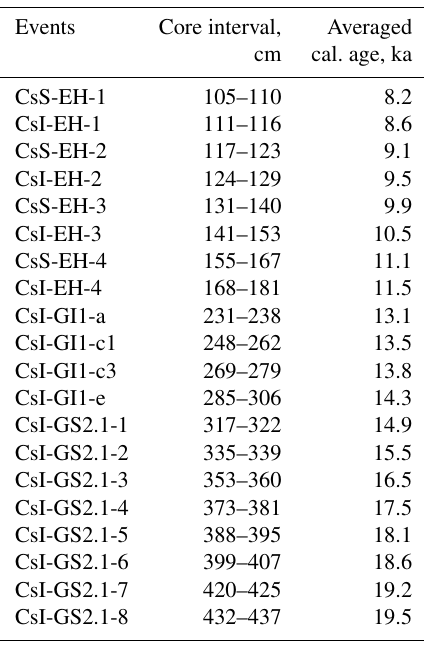
Table 2. Centennial events with increased/decreased productivity during 25–8ka in core 41-2 and the average ages according to the correlations between productivity events and the EASM sub- interstadials and sub-stadials